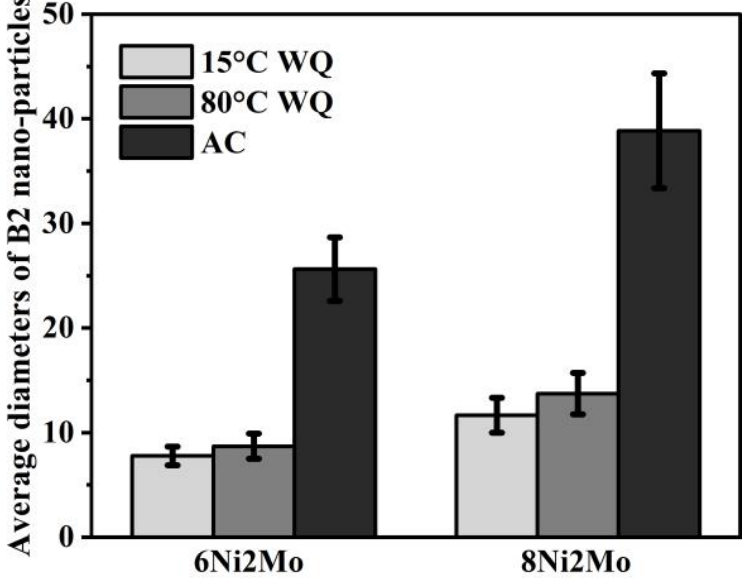
Figure 4. Average diameters of B2 nano-particles for the solution-treated 6Ni2Mo and 8Ni2Mo alloys followed by 15 °C WQ, 80 °C WQ or AC.